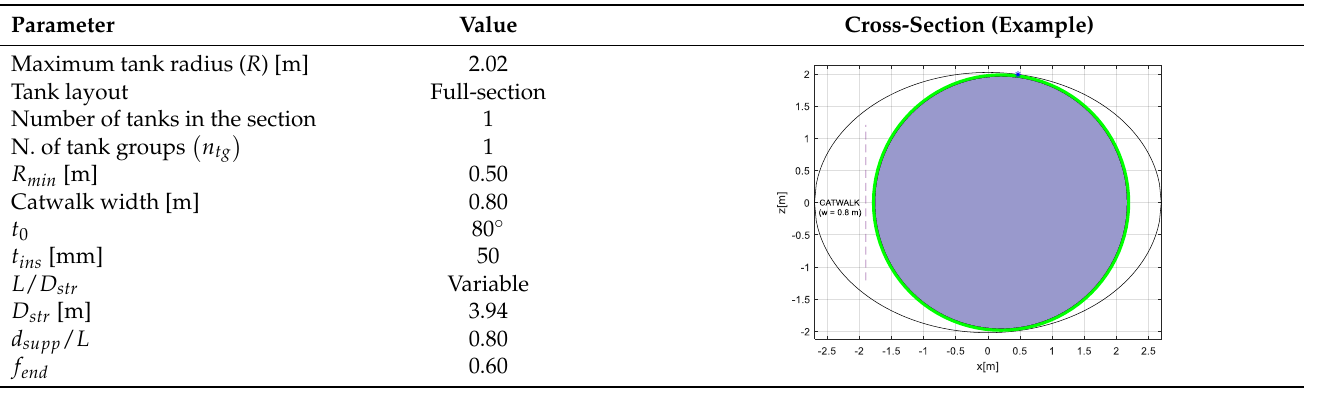
Table 9. Data on the reference single tank/full section configuration with a catwalk.